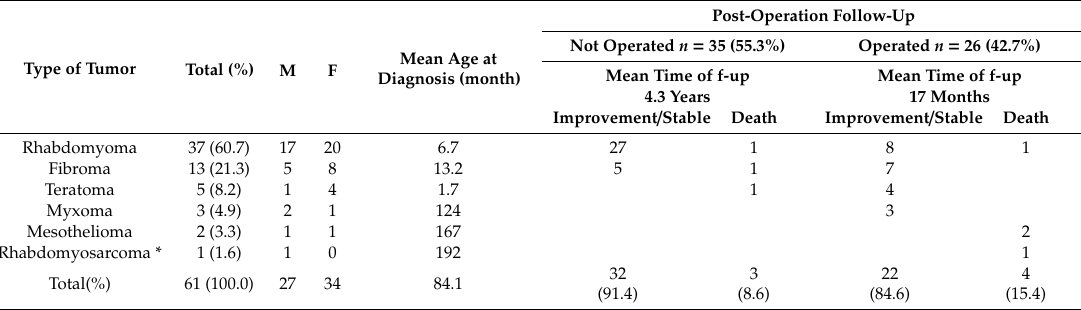
Figure 2. Two-dimensional echocardiography: parasternal long axis image obtained in the same patient as in Figure 1, after subtotal resection of tumor. Although the tumor was removed completely, infiltration of the left atrial wall was found. The thickening of the left atrial wall and its irregular shape are clearly visible (*). Pericardial effusion (PEff) is also present about 1 cm behind the posterior wall of the LV. Abbreviations as in Figure 1. Table 3. Detailed analysis of the tumor type, gender, age at diagnosis, frequency, surgical treatment and